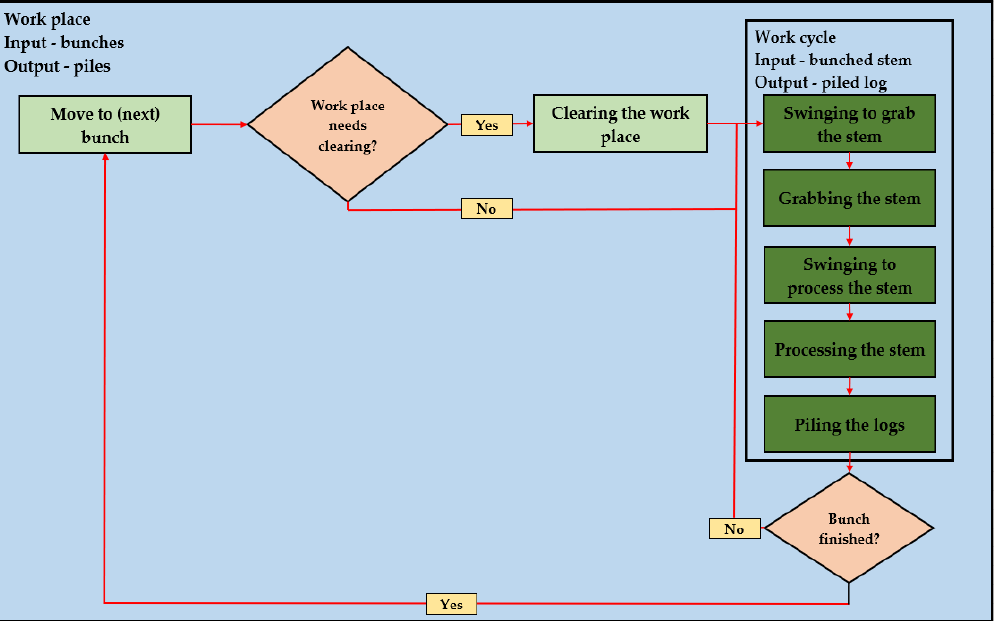
Figure 2. Functional description of the observed process.